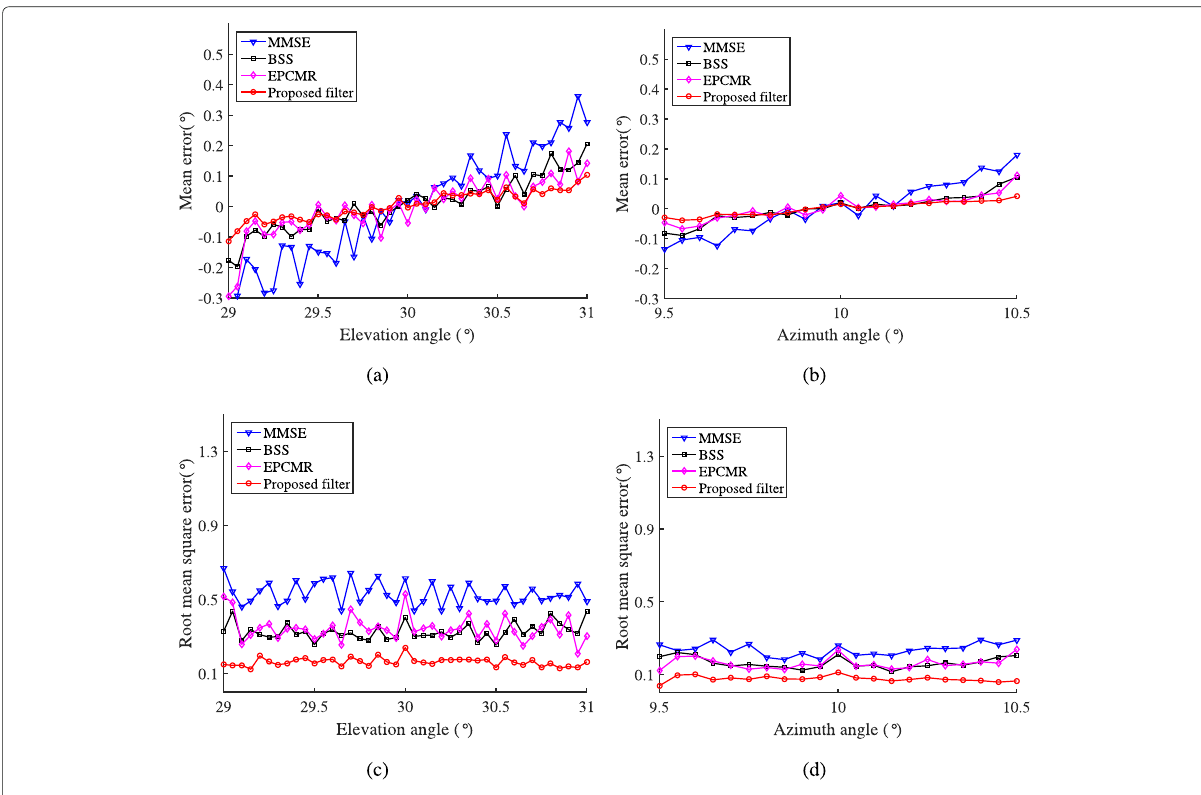
Fig. 5 Relative angle estimation performances